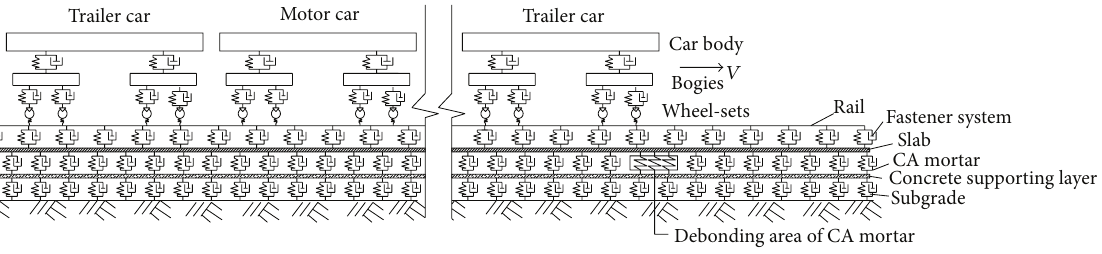
Figure 2: Vehicle-track-subgrade vertical coupling vibration plane